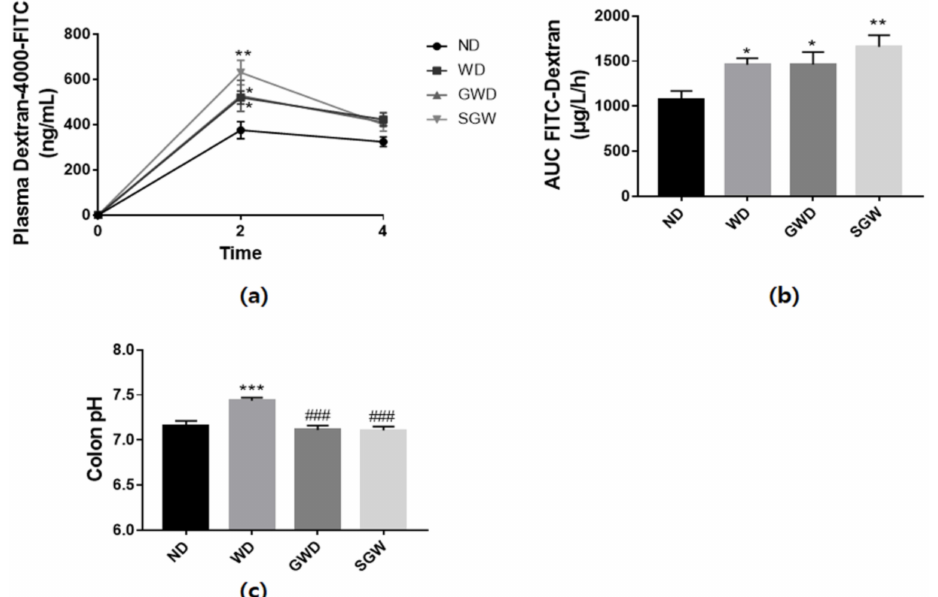
Figure 3. Diet-induced changes of gut barrier function. ( a ) Plasma fluorescein isothiocyanate (FITC)-dextran concentration during the gut permeability test; ( b ) Area under the curve (AUC) of plasma FITC dextran levels; ( c ) Colon pH levels. Data are presented as mean ± SEM for 9 mice per each group. (* p < 0.05, ** p < 0.01, *** p < 0.001 vs. ND; ### p < 0.001 vs.